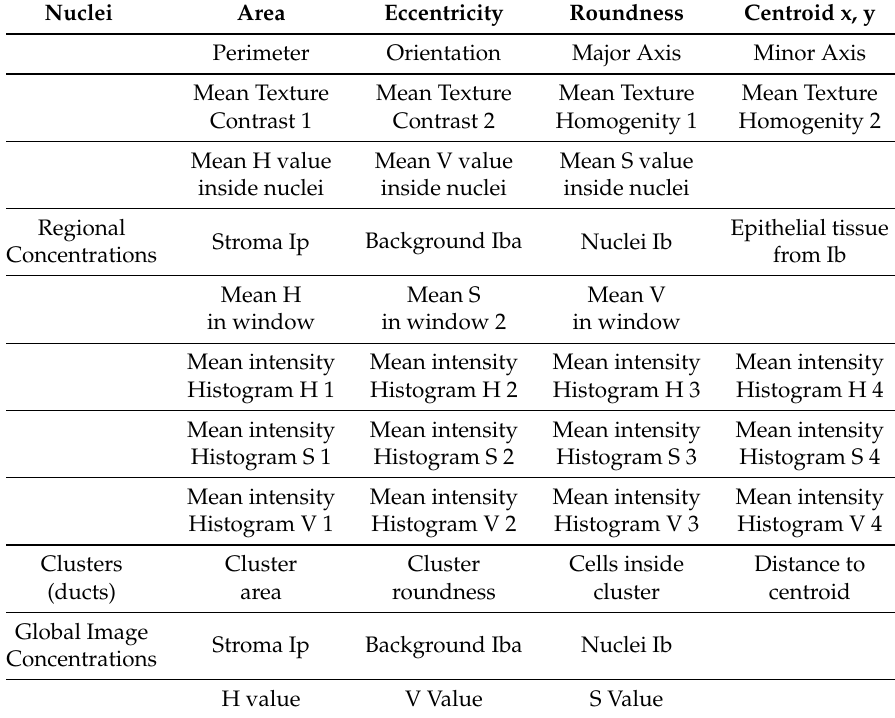
Table 1. Summary of extracted features. Features at regional level are computed at four different window sizes. Features from the full image represent average